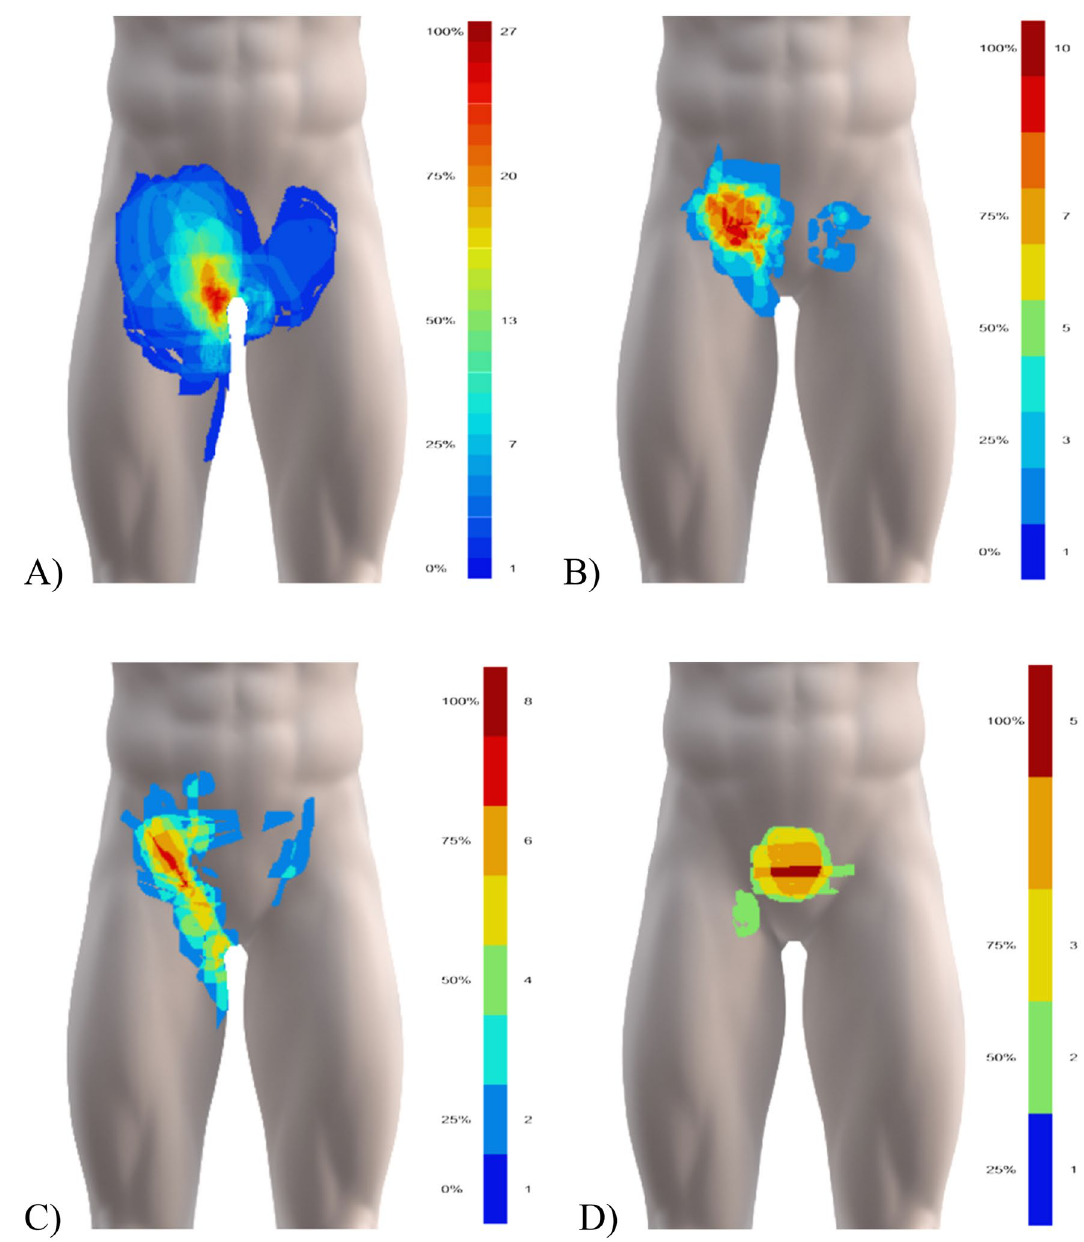
Figure 3. Pain map overlays of: ( A ) adductor- (N = 39), ( B ) inguinal- (N = 24), ( C ) iliopsoas- (N = 18), and ( D ) pubic-related (N = 7) groin pain showing common regions for each clinical entity. The colour-scheme range reflects the maximum overlap and the minimum one overlapping area, shown in percent and the absolute number of drawings. Areas drawn by only one individual are not shown in the summary figures. Before overlaying, unilateral left-sided pain drawings were flipped right, and bilateral pain drawings flipped, so the largest drawn area is on the right